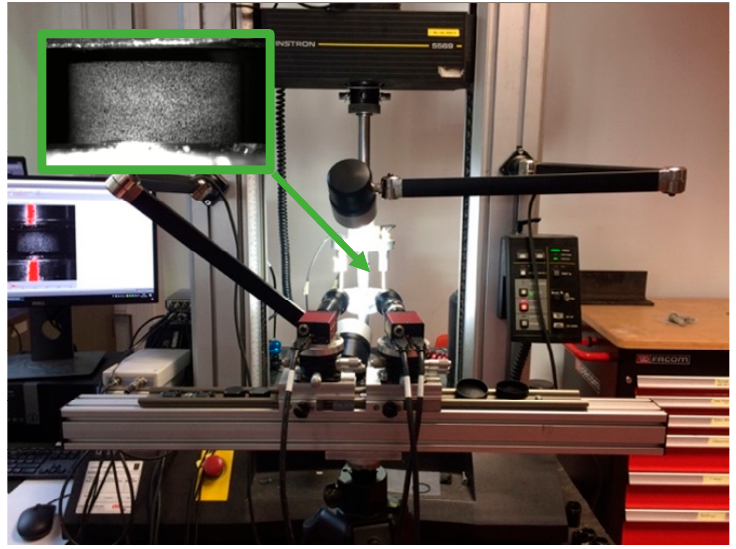
Figure 3. Quasi-static compression setup with magnified speckled sample (top left).